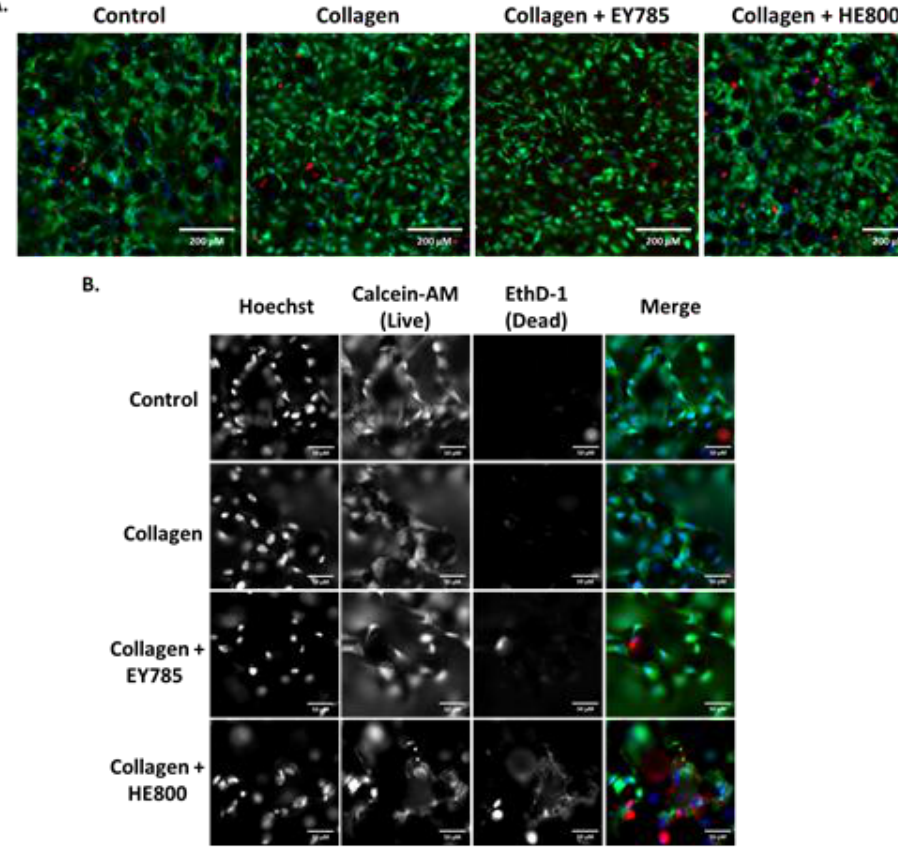
Figure 4. Fluorescence microscopy imaging of MG63 cells on Ti6Al4V samples after 7 days. Control: bare Ti6Al4V; blue: Hoechst staining; green: calcein-AM staining; red; Ethd-1 staining. ( A ) Images taken in widefield; ( B ) images taken at 5× magnification (with channels split). Scale bars: (A) 200 μm; (B) 50 μm.